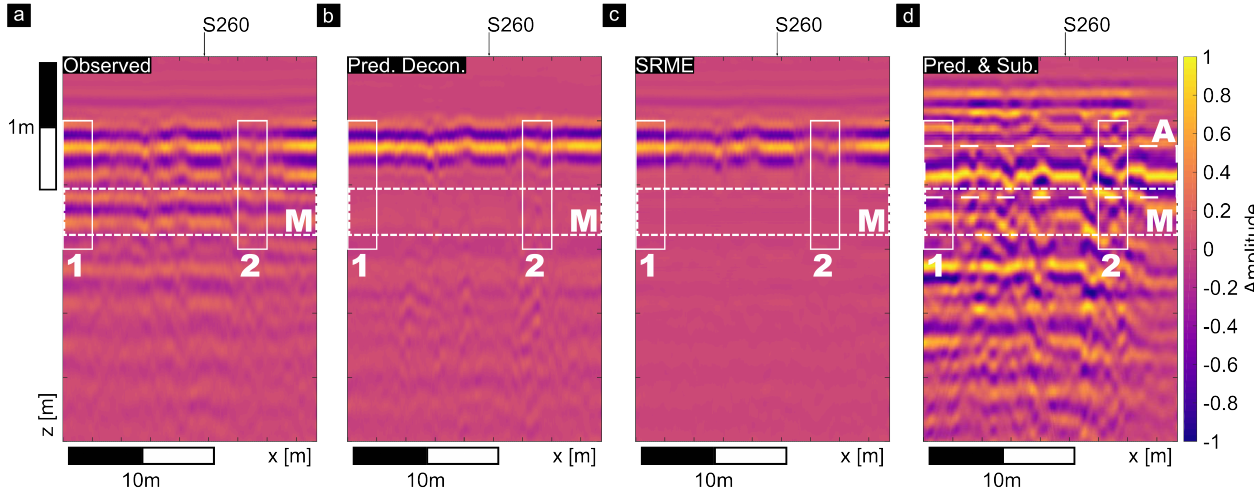
Figure 10. Constant-offset section of field data set 1 from Puck, Poland. The original data is shown in panel ( a ) and results of the multiple attenuation approaches are shown in panels ( b – d ). The extracted multi-offset section S260 (Figure 9) is highlighted by a black arrow. The white boxes 1 and 2 mark details shown in Figures A2 and A3. In the result of the Prediction and Subtraction approach an enhanced reflection is highlighted by a white box with a dashed line (A). In Figure 11 the traces for shot 260 of the constant-offset section were compared with the observed data for each applied method. Further, the forward modeled trace which